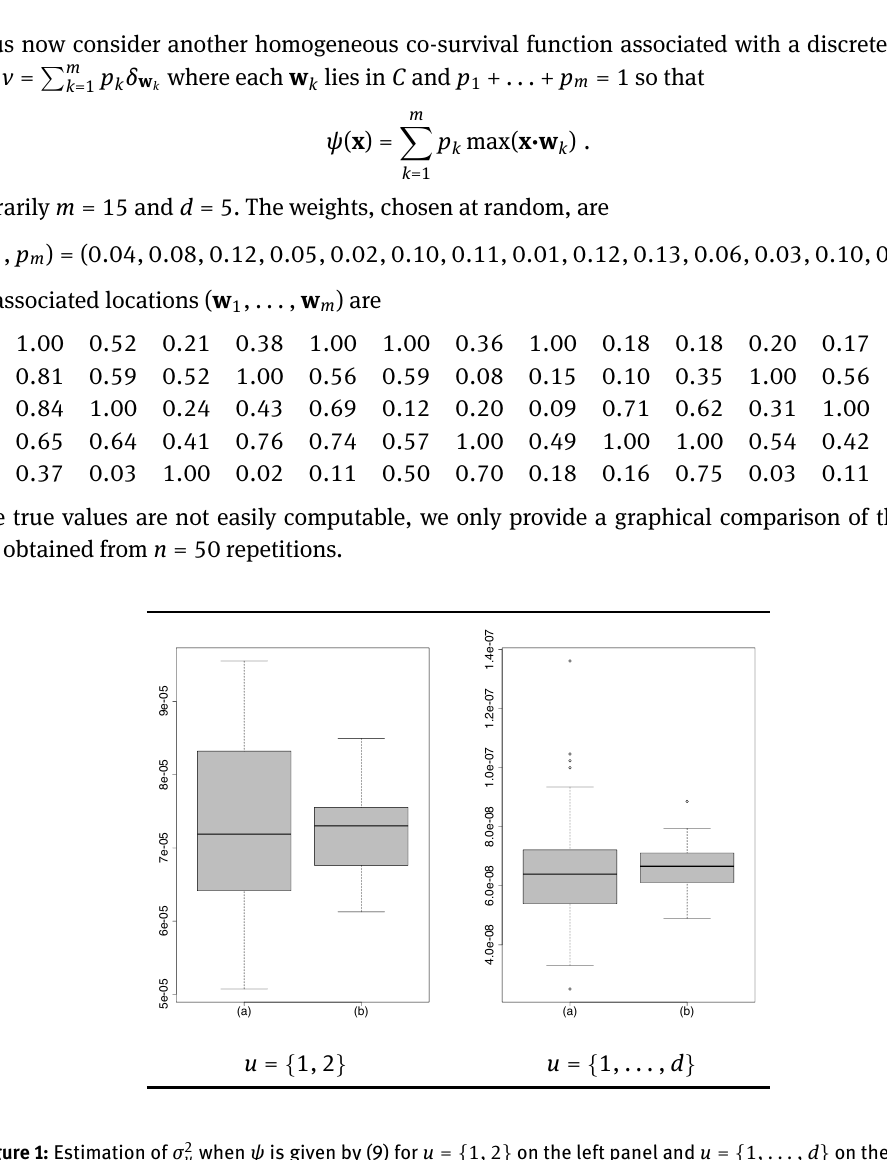
Figure 1: Estimation of σ 2 u when ψ is given by (9) for u = { 1, 2 } on the left panel and u = { 1, . . . , d } on the